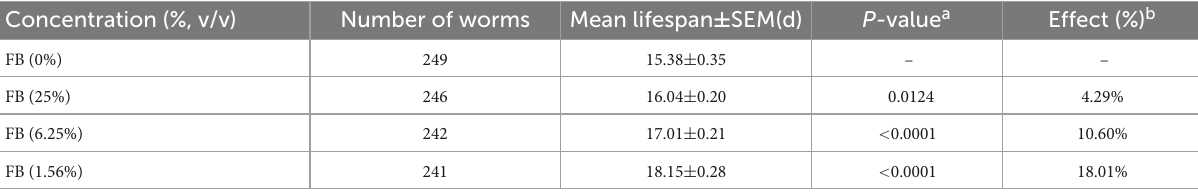
TABLE 2 The effect of FB on the lifespan of C. elegans.